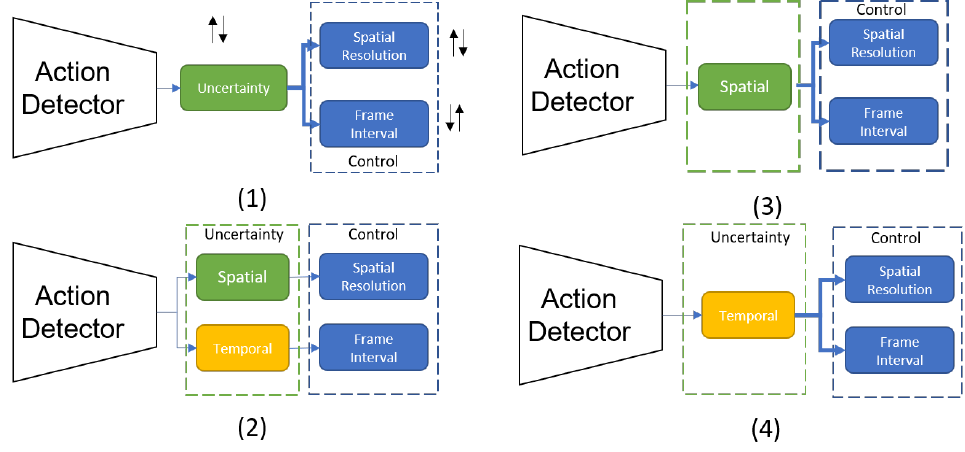
Figure 18. The spatial and temporal uncertainty are connected to the control parameters in 4 different